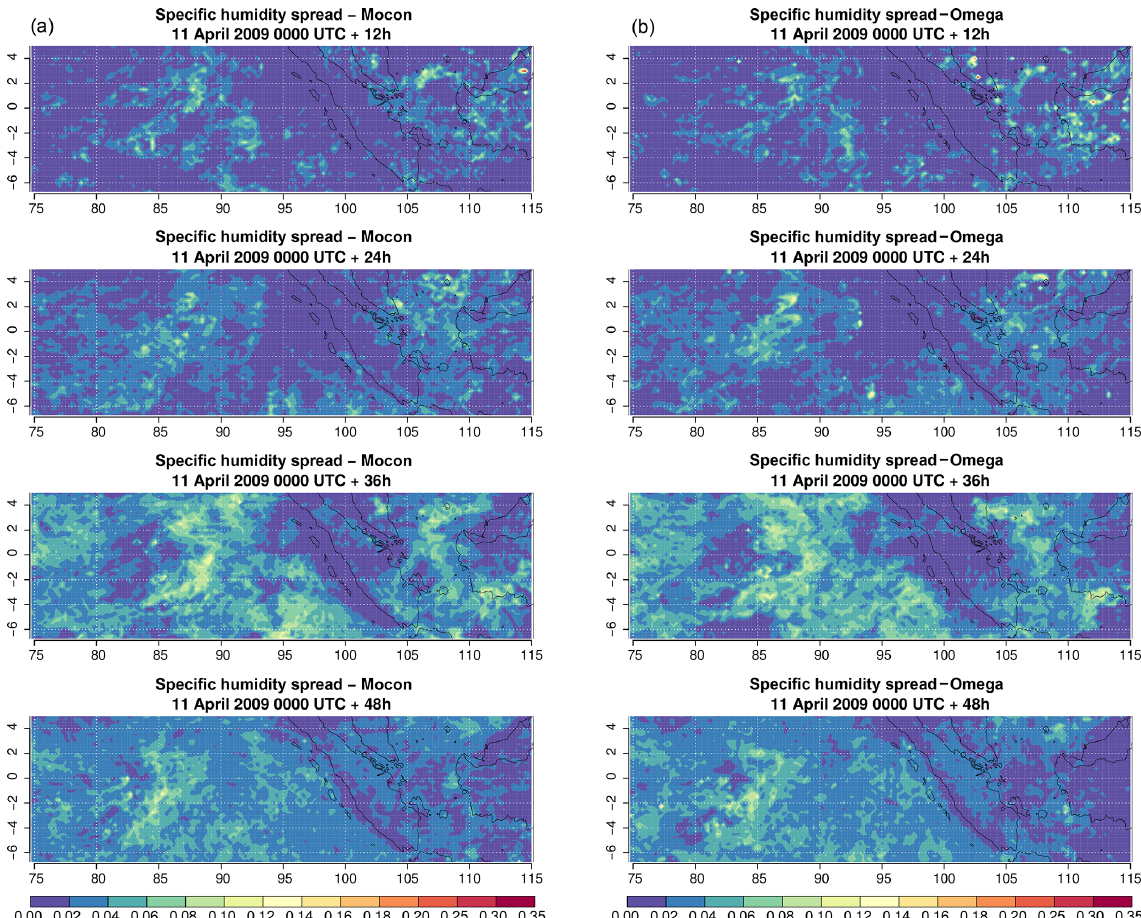
Figure 12. Snapshots of the specific humidity spread (gkg − 1 ) at 250hPa for the MOCON (a) and OMEGA (b) ensemble without perturba- tions in ICs and LBCs. Snapshots are shown for every 12h during the 48h forecast started at 00:00UTC on 11 April